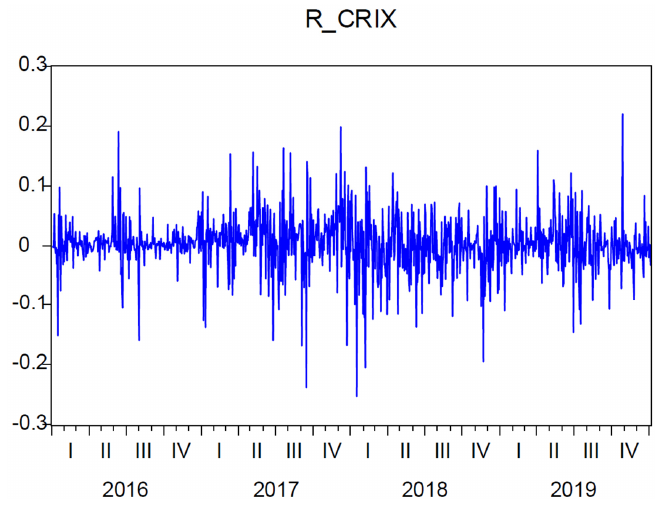
Figure 1. Line-graphs: BTCUSD and CRIX.